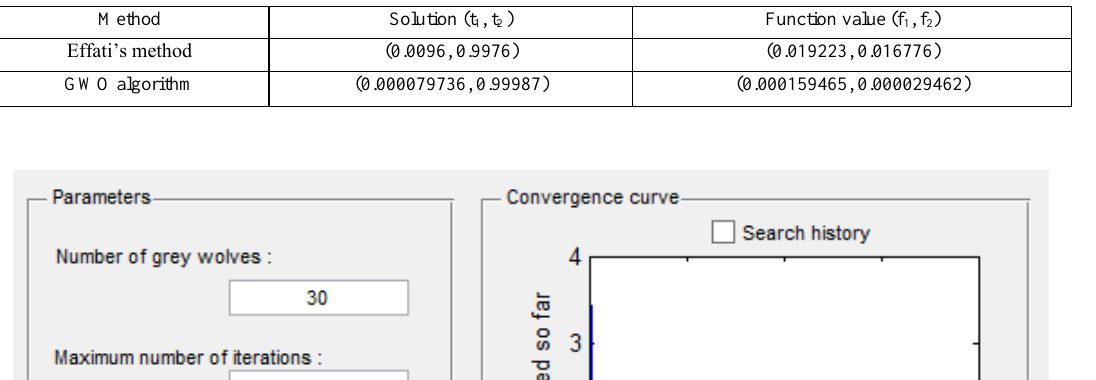
Table 4. Results for Problem 2